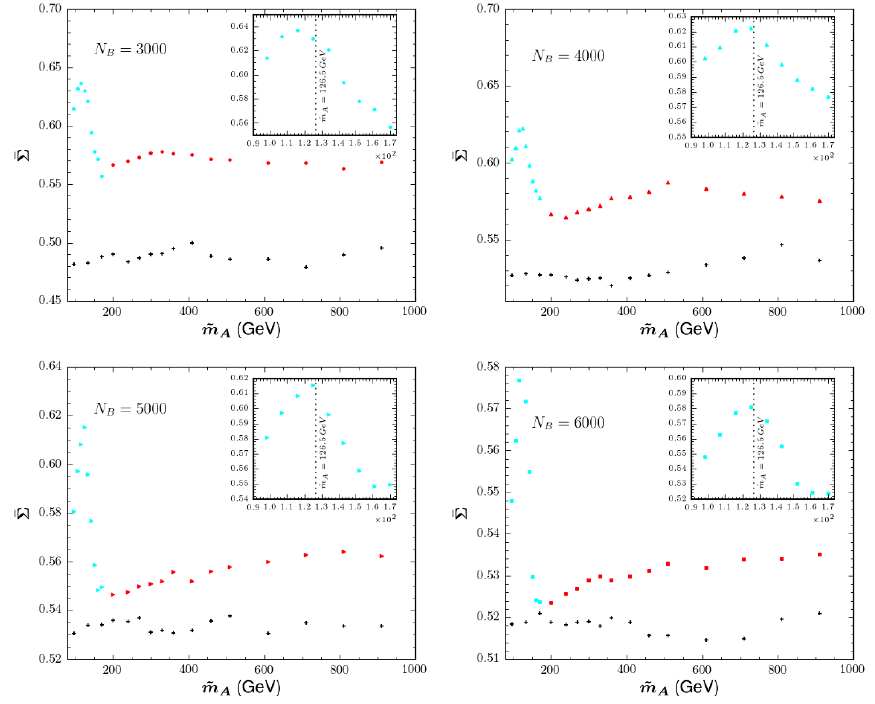
Figure 25 . The same as (cid:12)gure 13, but using study point P